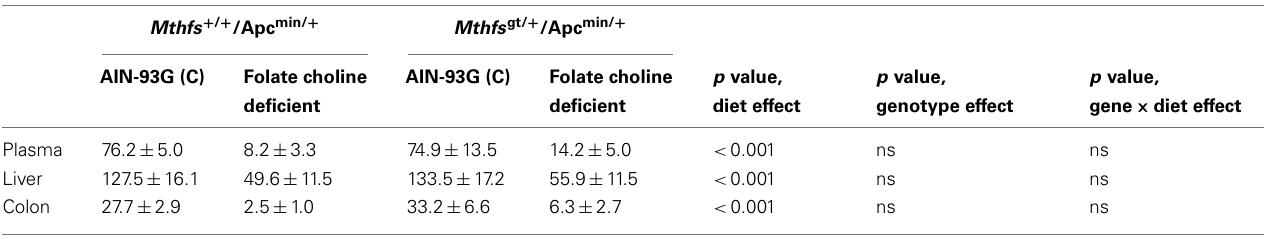
Table 3 | Folate levels of Mthfs + / + /Apc min/ + and Mthfs gt/ + /Apc min/ + tissues after 11weeks onAIN-93G andAIN-93G lacking folate and choline.